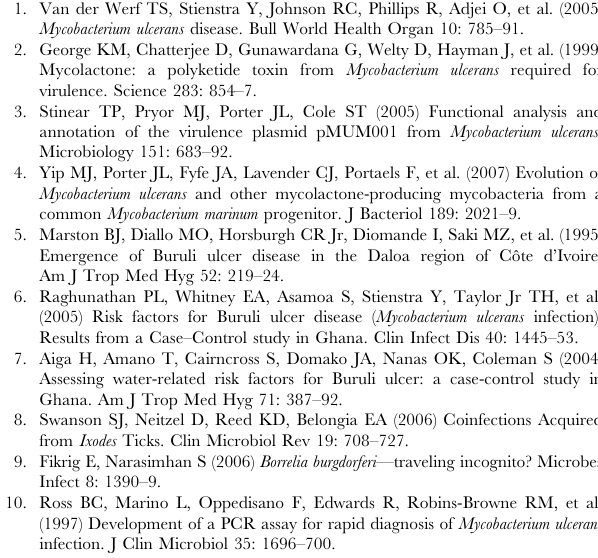
Figure S1 ER PCR and VNTR profiling of representative samples collected 2004–2006. A. ER PCR of various sample types. Lanes are labeled 1: 1KB ladder; 2: Water blank DNA extraction;